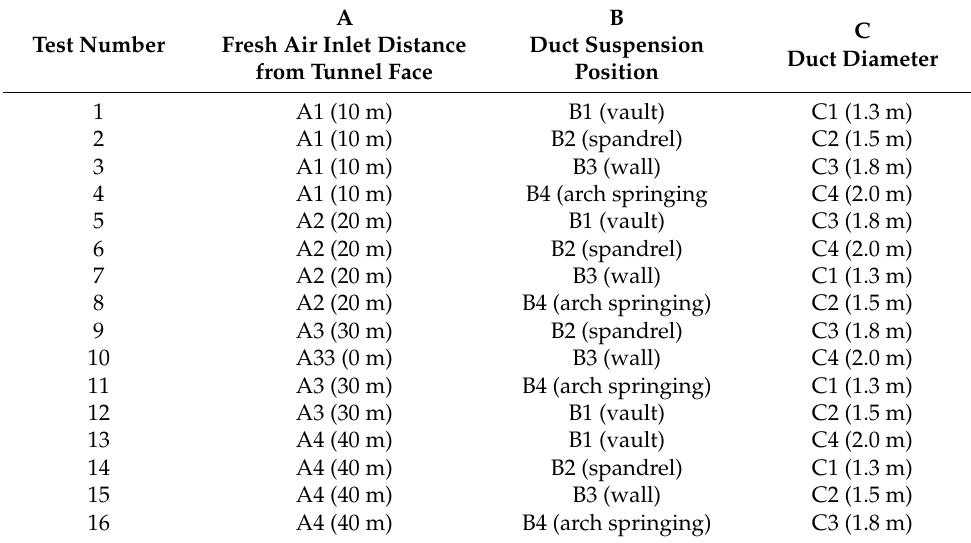
Table 4. Orthogonal numerical simulation test